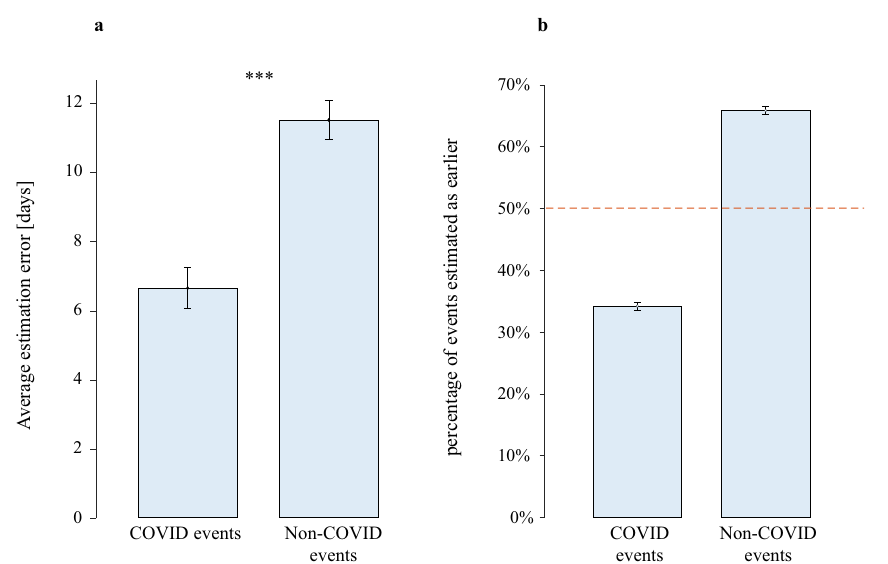
Figure 3. COVID vs. Non-COVID estimation errors for 11 pairs of events. ( a ) Average estimation errors based on the first stage of the experiment. While both types of events show time inflation, time estimation for the non-COVID events was significantly more inflated than for COVID events. ( b ) Percentage of COVID vs. non- COVID events estimated as less recent within their pair, based on the second stage of the experiment. Dashed line represents the percentage of the events that were less recent (very near 50% COVID and 50% non-COVID). Consistently with findings of the first stage, these results show that Non-COVID events were perceived to be less recent than their counterpart COVID events. *** p <